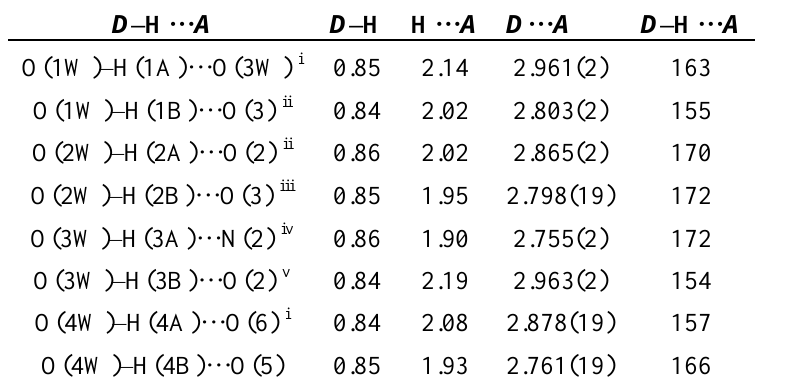
Table 1. Hydrogen-bond geometry (Å,